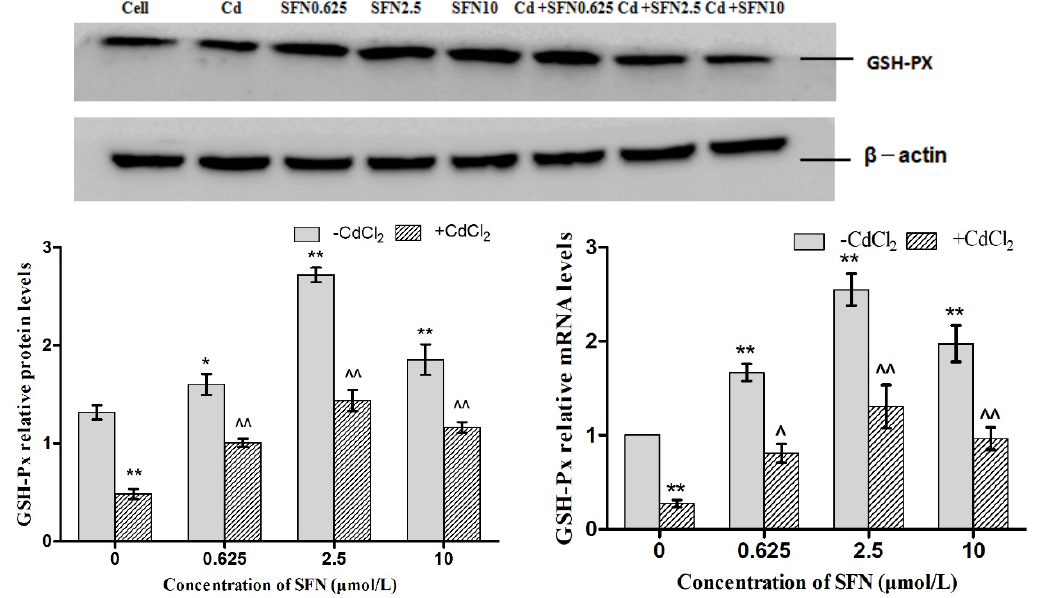
Figure 11. Effects of SFN on Cd induced the relative mRNA and protein expression of GSH ‐ Px of the TM4 cells. * p < 0.05 as compared to the control group, ** p < 0.01 as compared to the control group, ^ p < 0.05 as compared to the Cd group, ^^ p < 0.01 as compared to the Cd group.